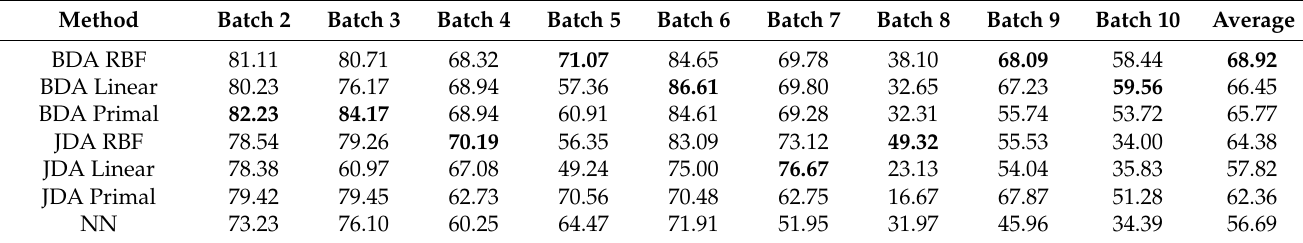
Table 5. Drift compensation results of BDA and other methods for Setting